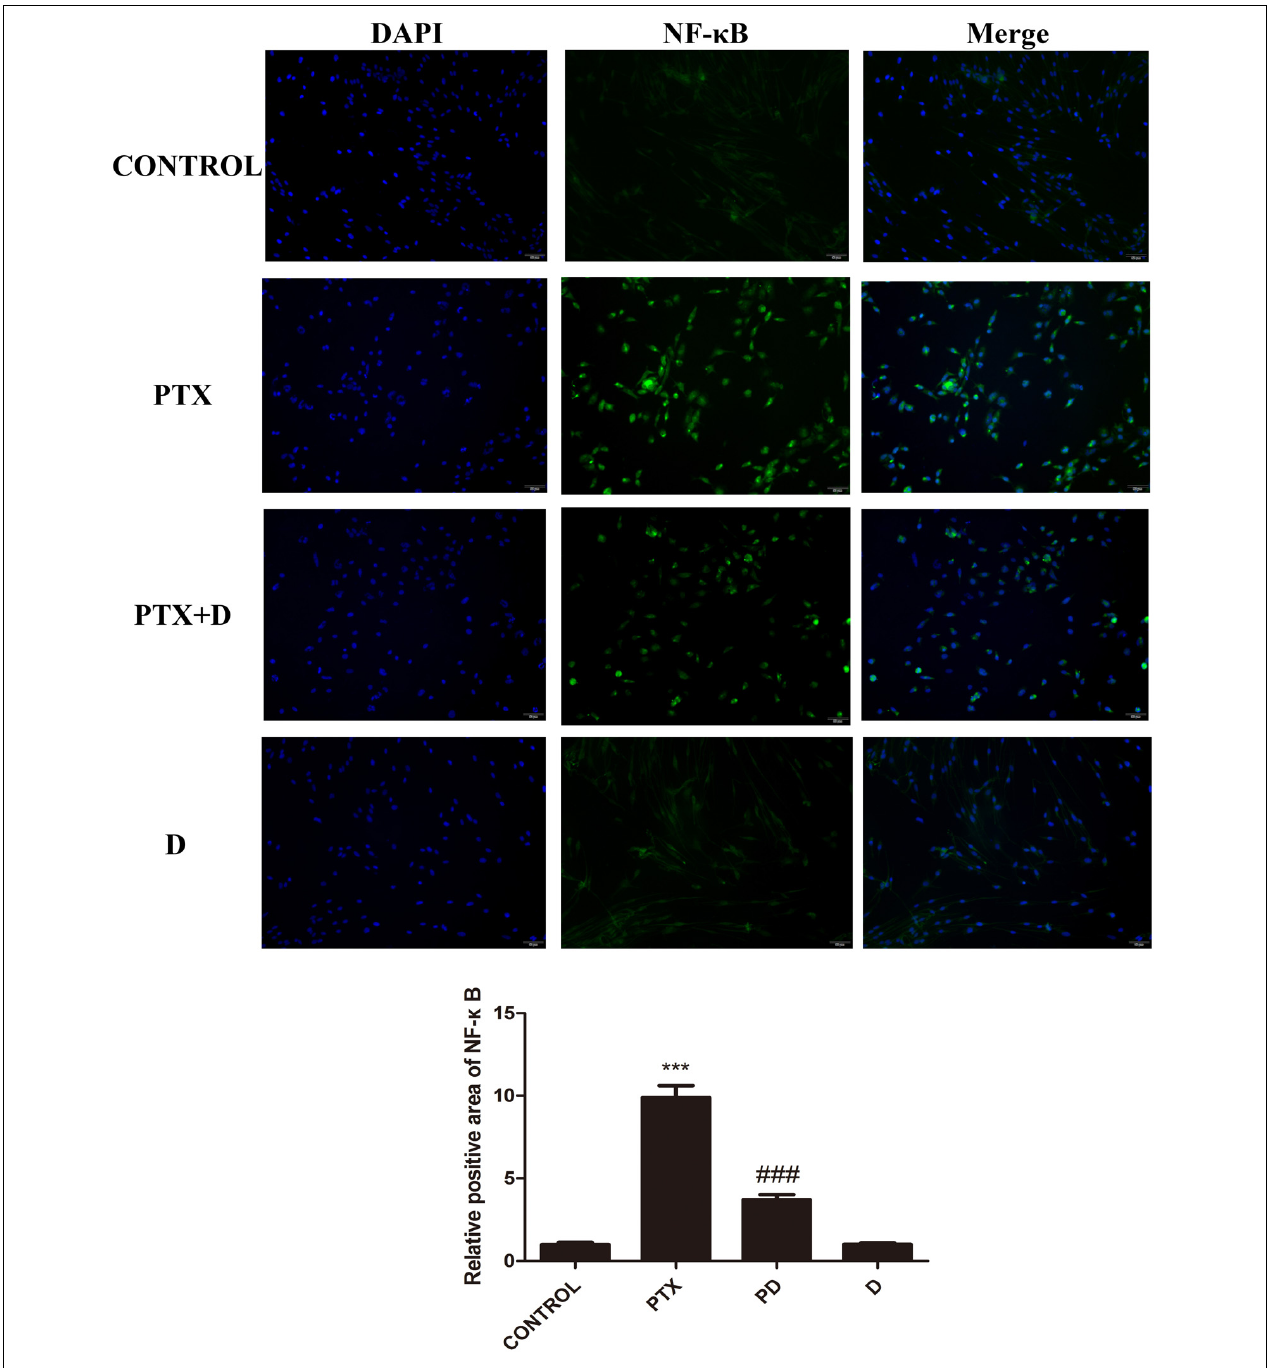
FIGURE 9 | Effect of paclitaxel and duloxetine on the expression of nuclear NF- κ B in DRG neuronal cells. DRG neuronal cells were treated with (or without) PTX (300 nM) and duloxetine (300 nM) for 24 h and were double-stained with DAPI and NF- κ B. The fluorescence intensity was observed using fluorescence microscopy ( × 200). ( ∗∗∗ p < 0.001 vs. control; ### p < 0.001 vs. PTX).